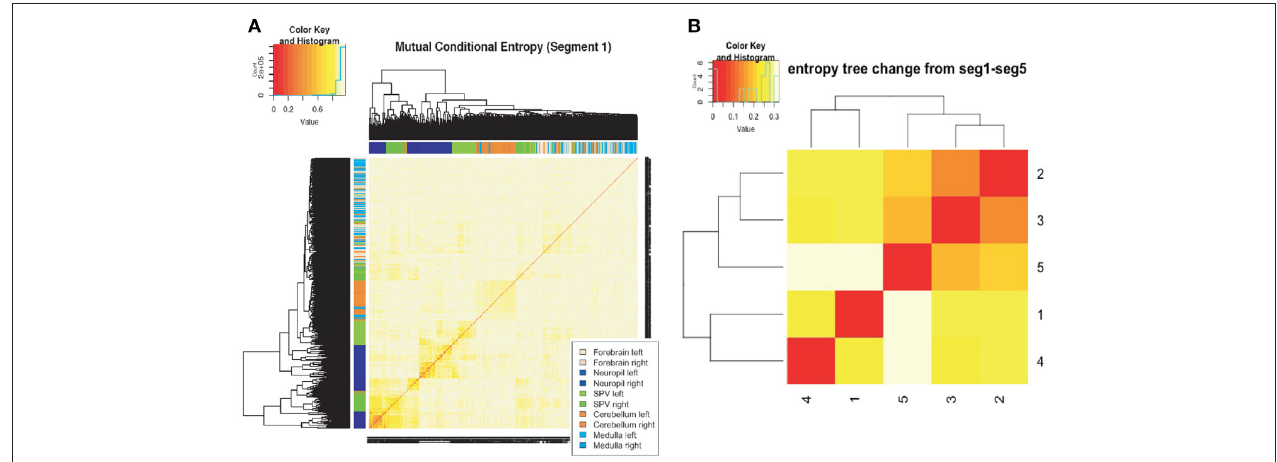
FIGURE 2 | Stability of spatial communities: (A) spatial communities identifies via blocks of mutual conditional entropy matrix on 685 pixels in the first inter-ictal period; (B) Low mutual conditional entropies among community memberships across all five inter-ictal periods. with k = 10. This selection is seemingly to counter the